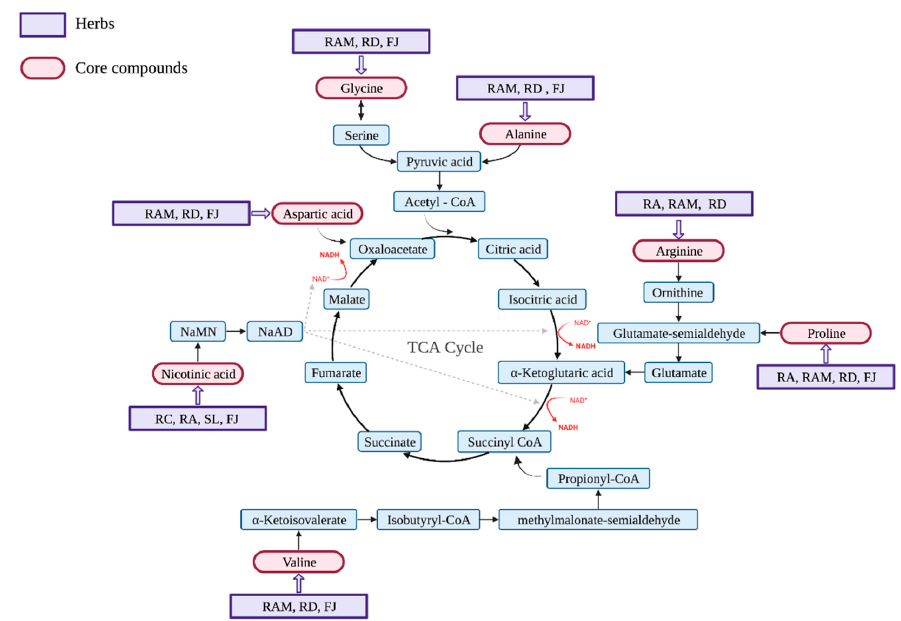
Figure 2. Summary of the energy metabolism of the unique compounds in humans. RA, Radix Astragali ; RAM, Rhizoma Atractylodis Macrocephalae ; RD, Rhizoma Dioscoreae ; FJ, Fructus Jujube ; RC, Radix Codonopsis ; SL, Semen Lablab Album ; TCA cycle, Tricarboxylic acid cycle; MaMN, nicotinic acid mononucleotide; NaAD, nicotinic acid adenine dinucleotide; CoA, coenzyme A.